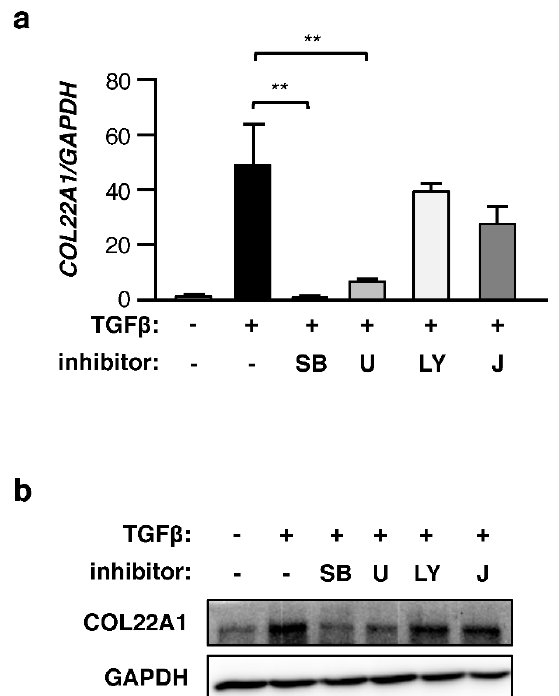
Figure 3. TGF β -induced COL22A1 expression is inhibited by MEK and ALK5 inhibitors. Skin fibroblasts were incubated with 10 µ mol/L SB431542 (SB), U0126 (U), LY294002 (LY), JNK inhibitor II (J), or DMSO as a vehicle control for 1 h before the addition of TGF β (5 ng/mL). Skin fibroblasts were stimulated with TGF β for 24 and 72 h. ( a ) Expression levels of COL22A1 were measured using qPCR